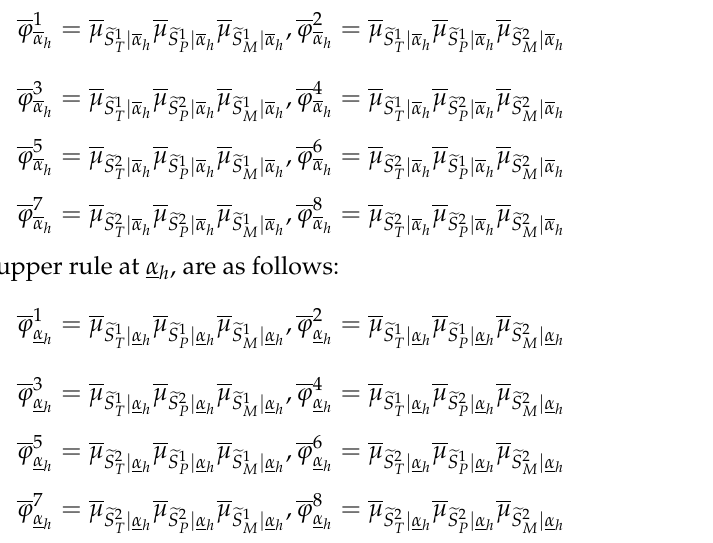
Figure 1. The structure of the type-3 fuzzy neural network. The calculation of upper rule firing at